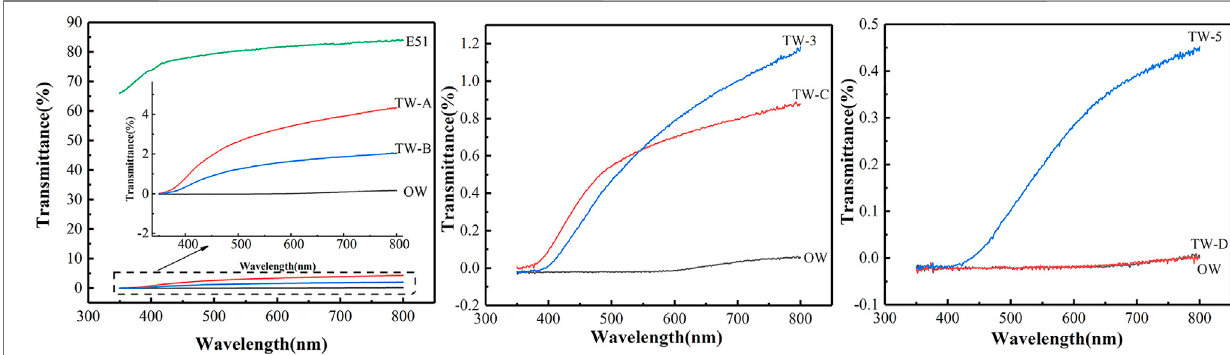
*The relative thicknesses of different layers are all 0.5 mm